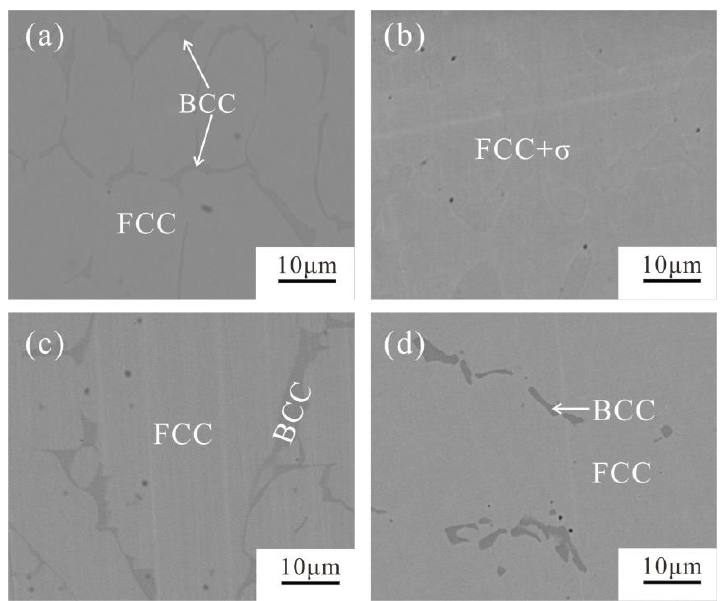
Figure 7. BSE micrographs of the alloys A3 and A15. ( a ) as-cast alloy A3, ( b ) 1000 annealed alloy A’3, ( c ) as-cast alloy A15, ( d ) 1000 annealed alloy A’15.